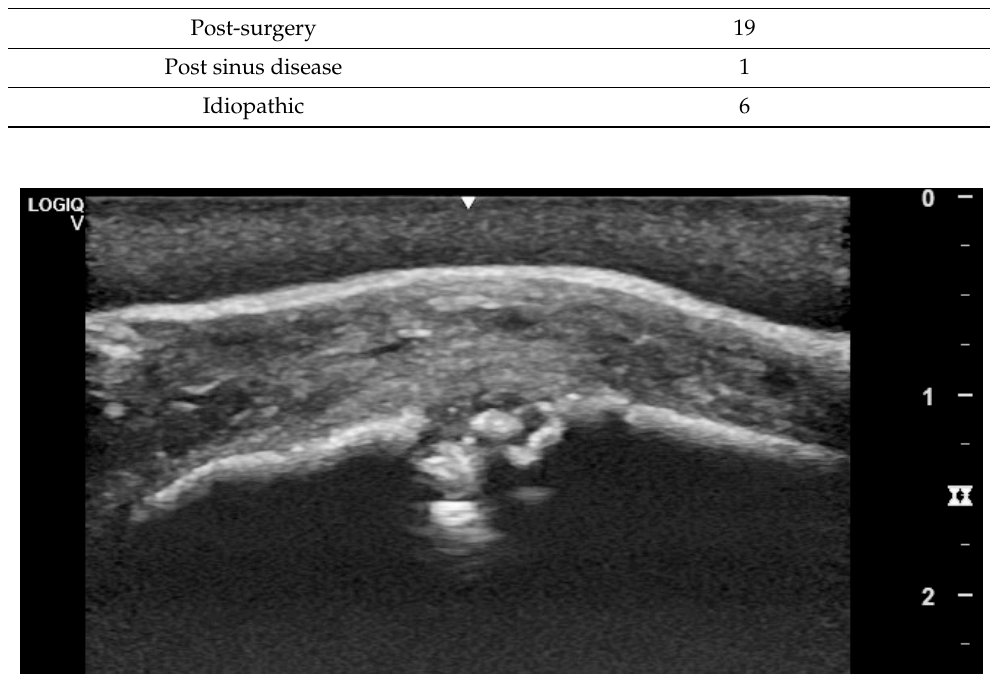
Figure 7. Ultrasonographic appearance of suture exostosis with central sequester formation. Note the thickened periosteum, subcutaneous tissue and skin. the thickened periosteum, subcutaneous tissue and